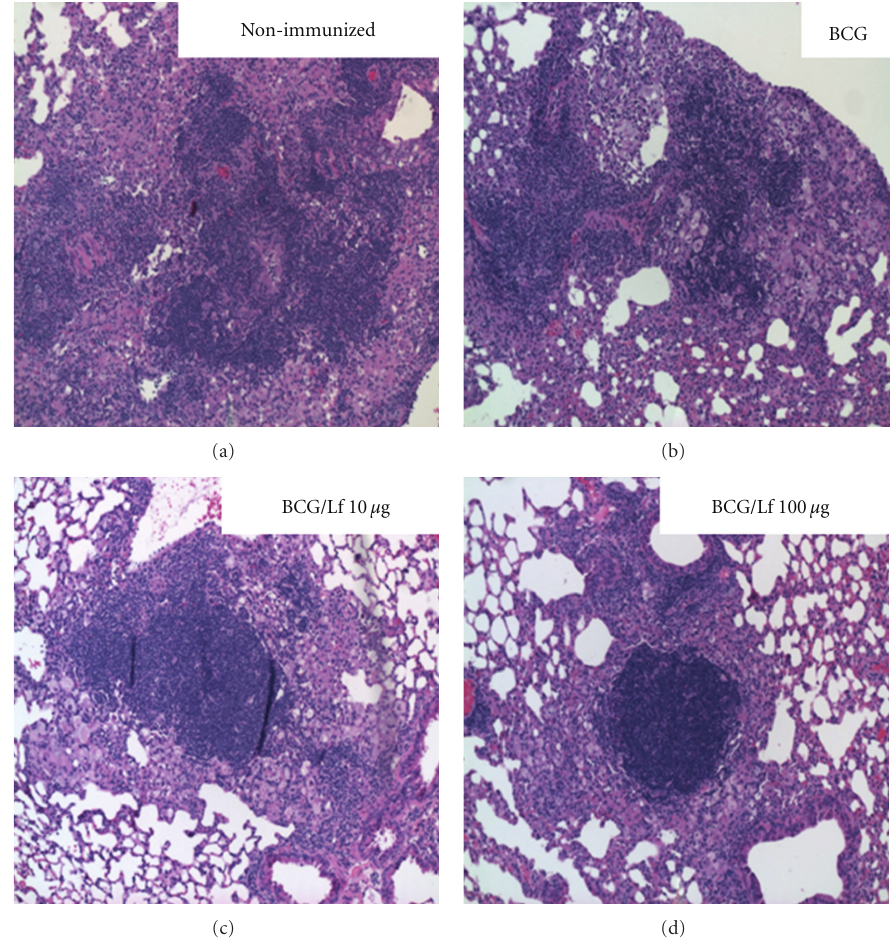
Figure 3: Protective histopathology following infectious challenge in lactoferrin adjuvant immunized mice. C57BL/6 mice were immunized as detailed in Figure 2 with BCG or BCG/bovine lactoferrin (10 or 100 μ g/mouse) and aerosol challenged 12 weeks after final boost. At day 65 postchallenge, lungs were collected, formalin fixed, and stained with hematoxylin and eosin (H&E). Comparison is made to nonimmunized, infected controls. A mixed presence of lymphocytes and activated macrophages indicative of a protective response is identified in the BCG alone vaccinated group. The addition of lactoferrin at either concentration resulted in a confined granulomatous response with focal lymphocytic accumulation and limited to no aggravated macrophage or polymorphonuclear insult. Images were visualized at 100x